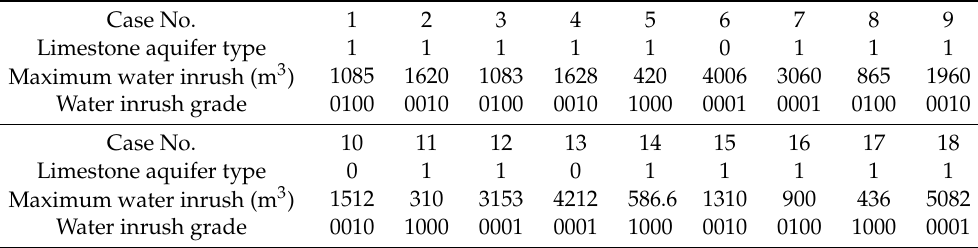
Table 3. Input information for water inrush